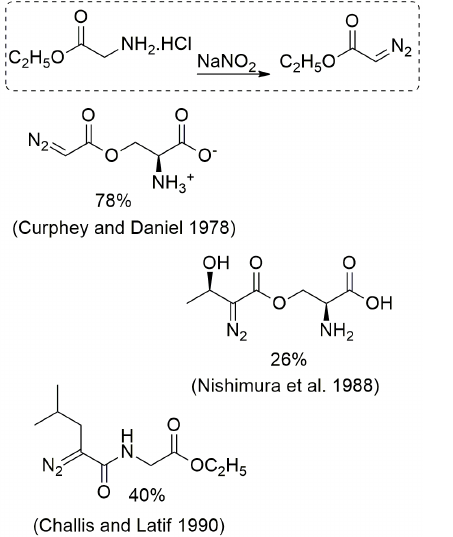
Figure 31 - Examples of synthesis and applicability of fluorinated